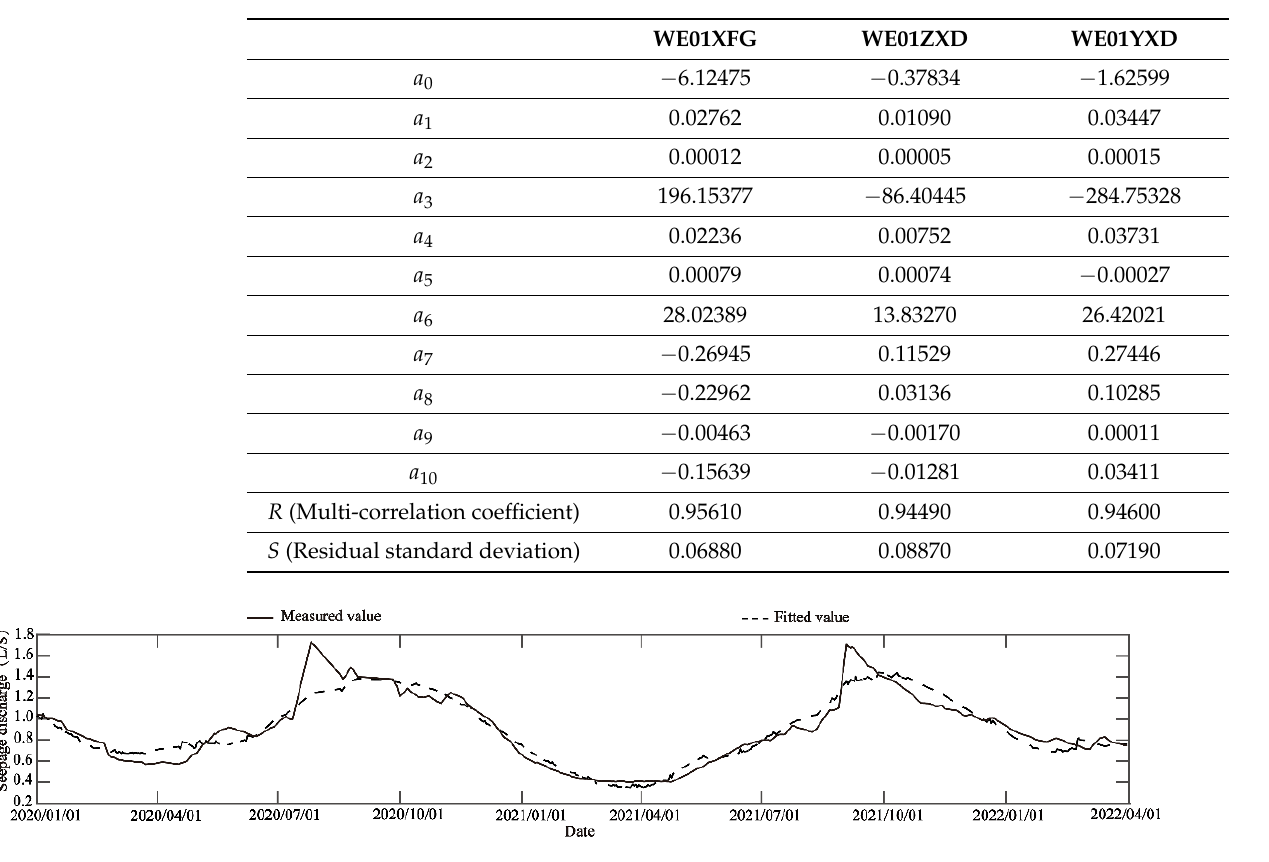
Table 1. Regression coefficients and characteristic values of seepage statistical models.